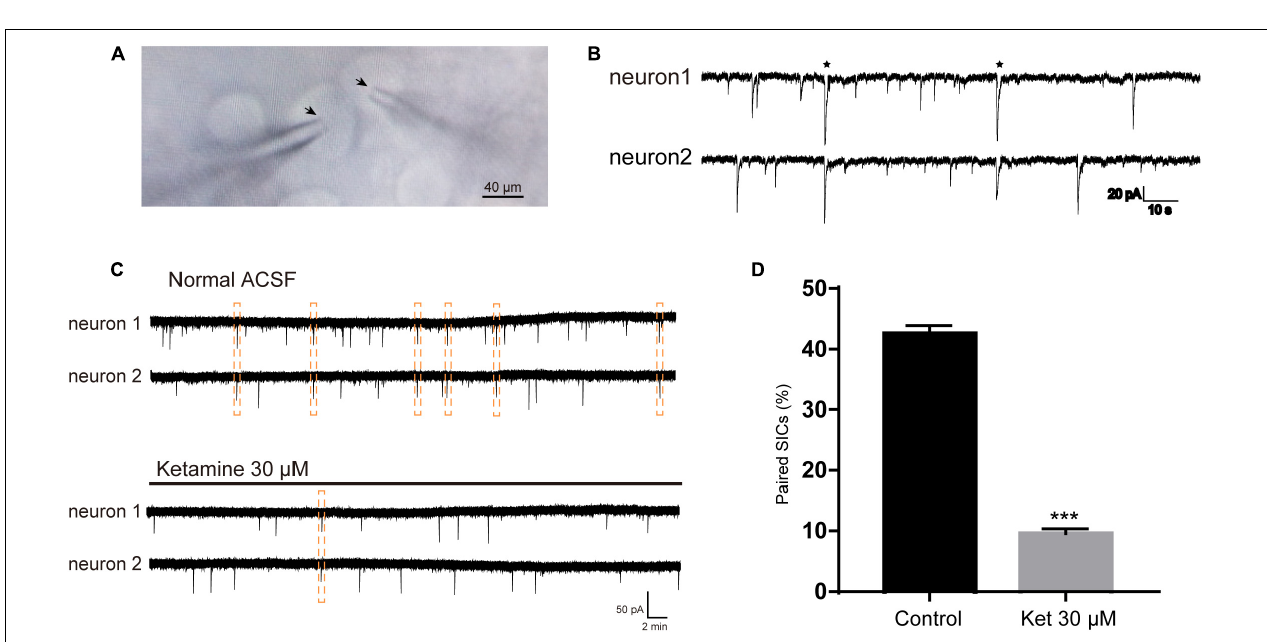
FIGURE 2 | Effects of propofol, dexmedetomidine and ketamine on SICs. (A) Example large scale traces of SICs exposed to the highest concentration of propofol, dexmedetomidine and ketamine. (B–D) bar graphs illustrate SICs frequency affected by three anesthetics with different concentrations. (E) Statistical summary of amplitude of SICs affected by three anesthetics with the highest concentration in this study. Differences with statistically significant ( ∗∗∗ p < 0.001, compared with control) were verified by one-way ANOVA followed by Brown-Forsythe test. Data were presented as mean ± SD. Con = control, Pro = propofol, Dex = dexmedetomidine, Ket = ketamine.